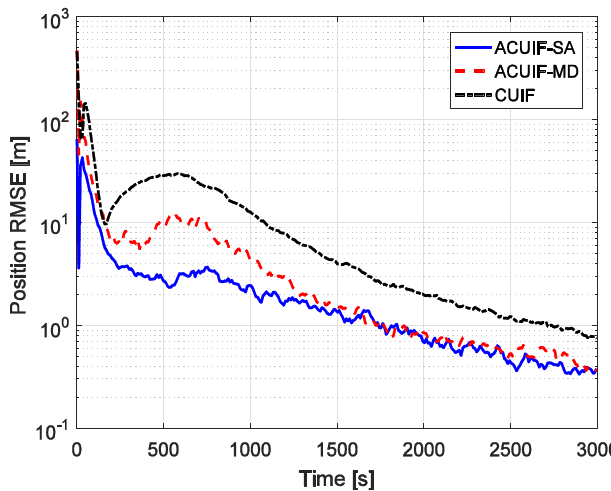
Sensors 2019 , 19 , x FOR PEER REVIEW Figure 1. The position root mean-squared error (RMSE) for different methods over time in case 1. Figure 2. The position root mean-squared error (RMSE) for di ff erent methods over time in case 1.